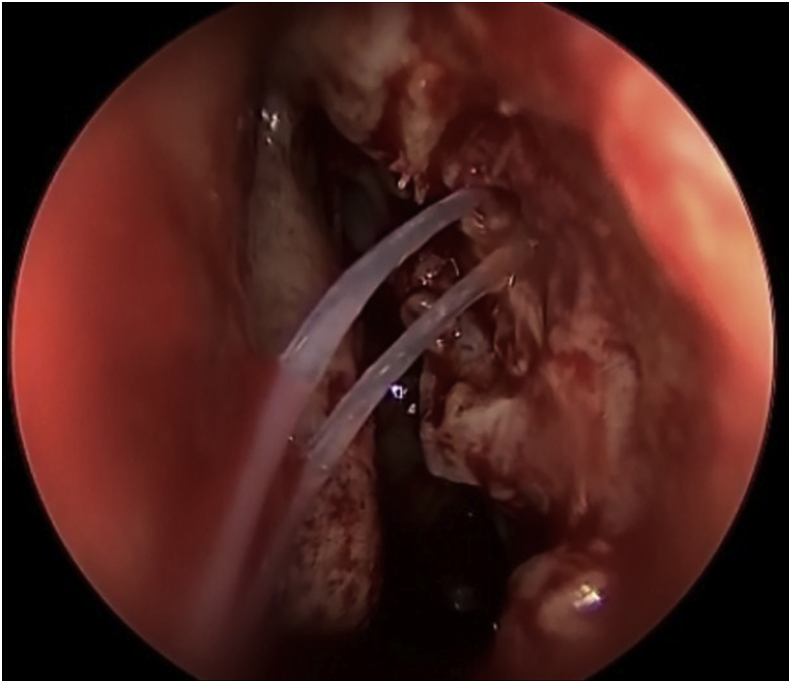
Repositioned flaps.